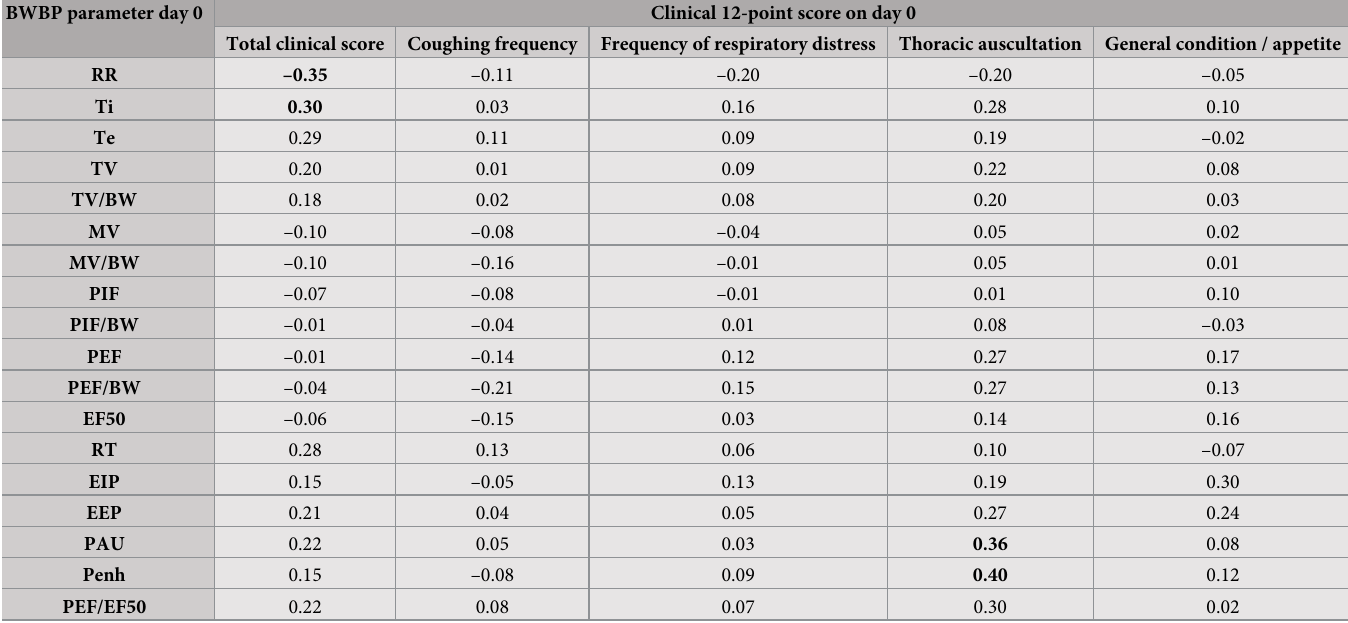
Bold values indicate p < 0.05.